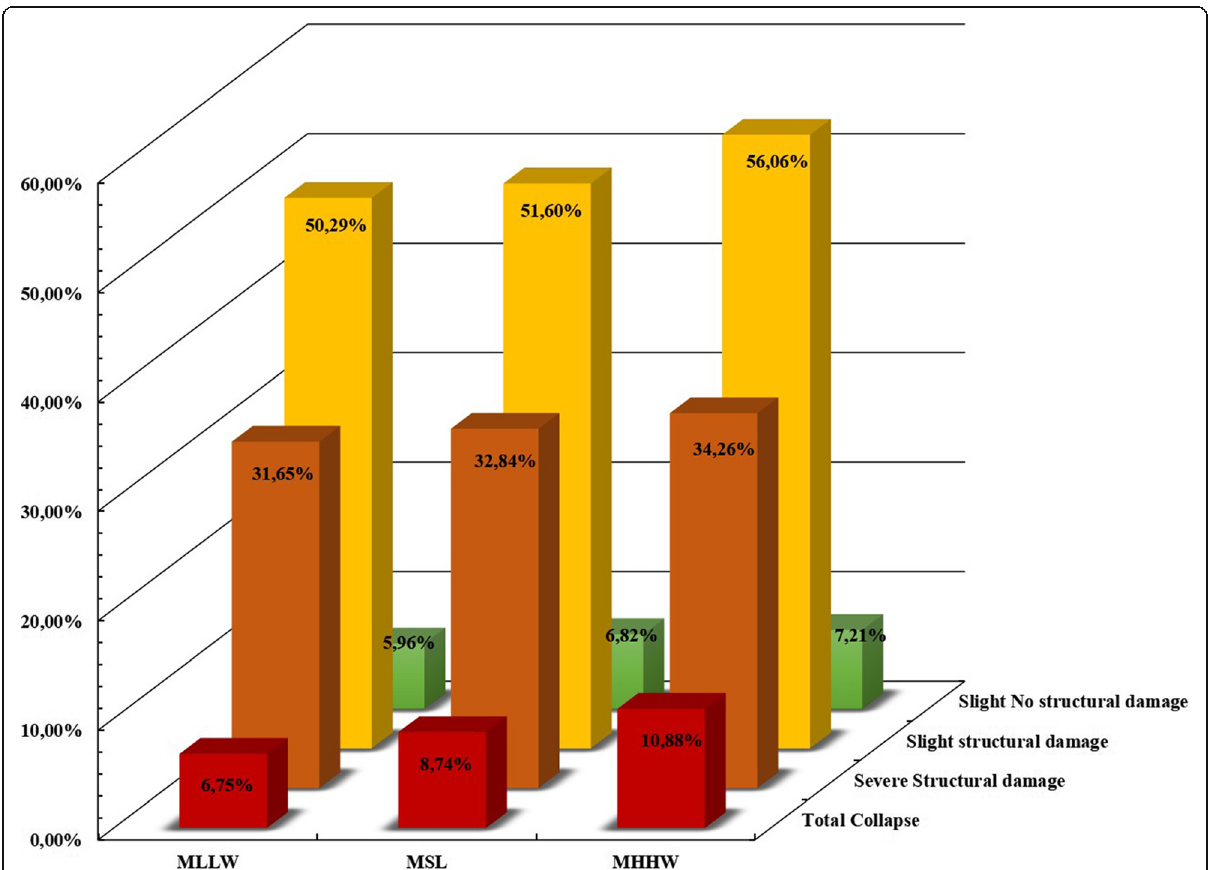
Fig. 7 Variations in the buildings tsunami vulnerability variations under the effect of the tidal